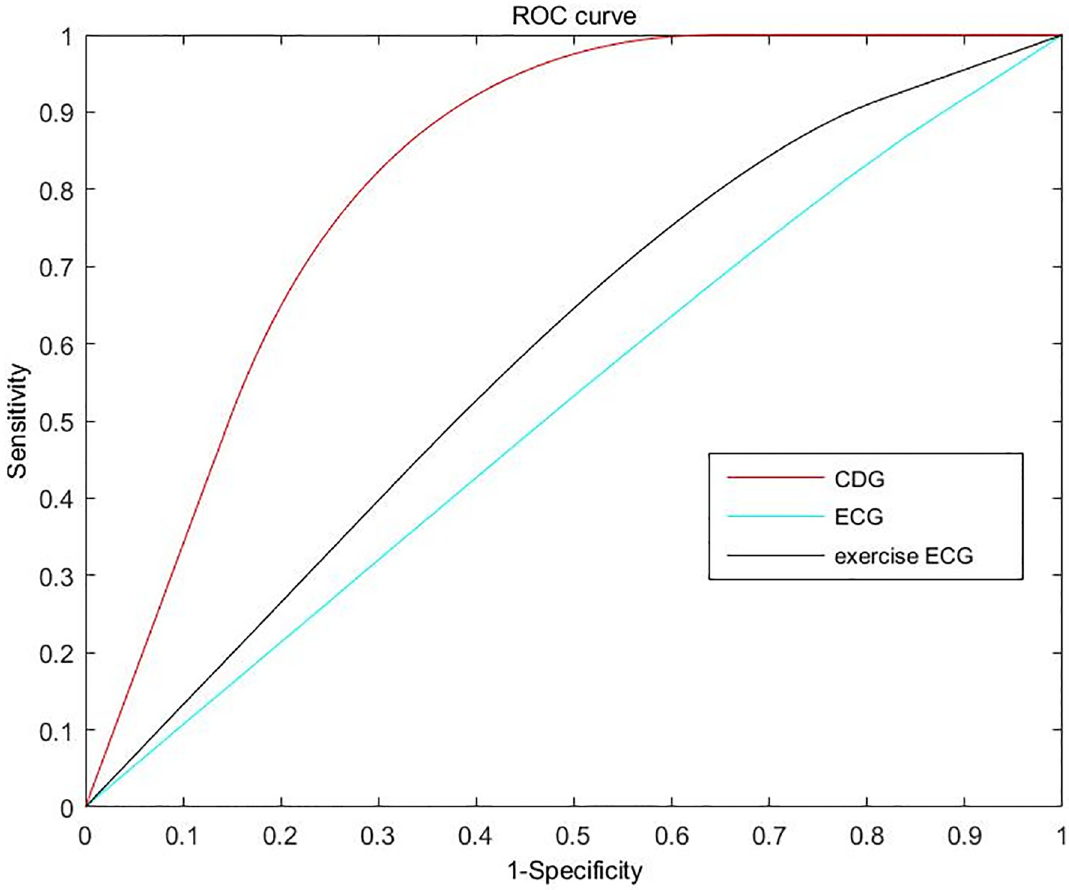
Fig 10. Receiver-operating characteristic curves of CDG, ECG and exercise ECG. The areas under the three ROC curves were 0.759 (the 95% confidence interval 0.653 to 0.865), and 0.521(the 95% confidence interval 0.396 to 0.645), 0.621(the 95% confidence interval 0.497 to 0.744),